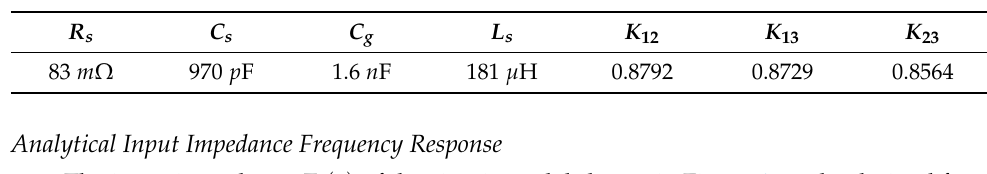
Figure 1. Three-Section Lumped Parameter Winding Model [8]. Table 1. Parameter values for the model shown in Figure